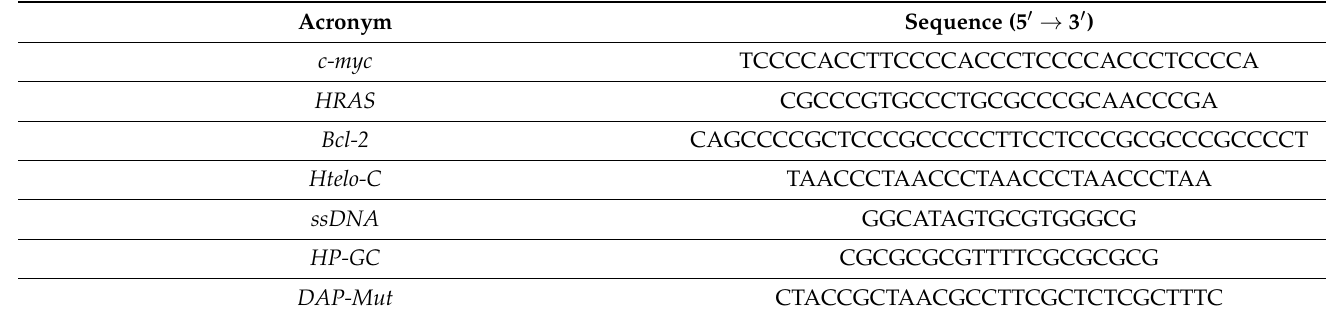
Table 1. Oligonucleotide sequences used in the present